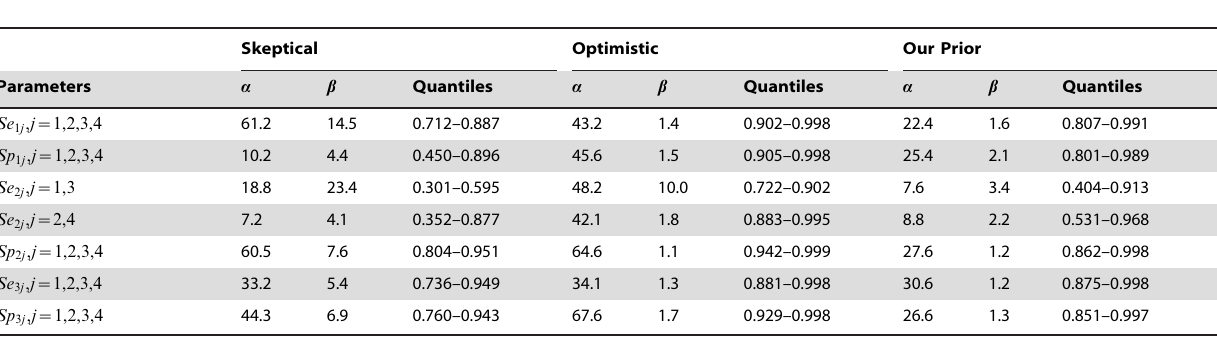
Table 6. Coefficients ( a , b ) and theoretical quantiles ( P 0 : 025 { P 0 : 975 ) of Beta distributions for sensitivities ( Se ij ) and specificities ( Sp ij ): a skeptical, a optimistic and our prior beliefs